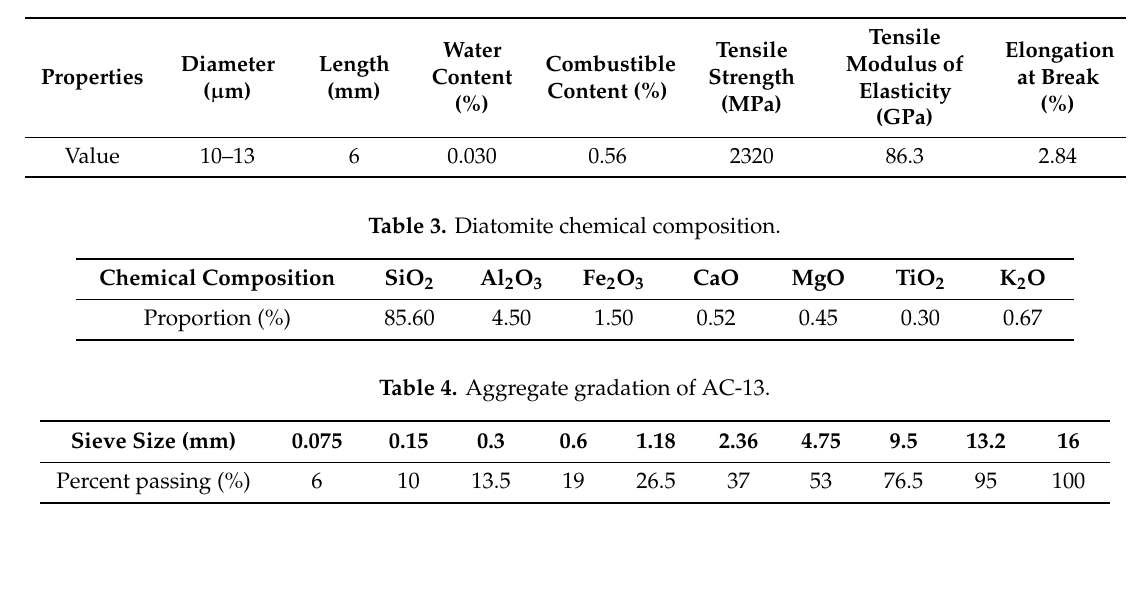
Table 2. Properties of basalt fibers.